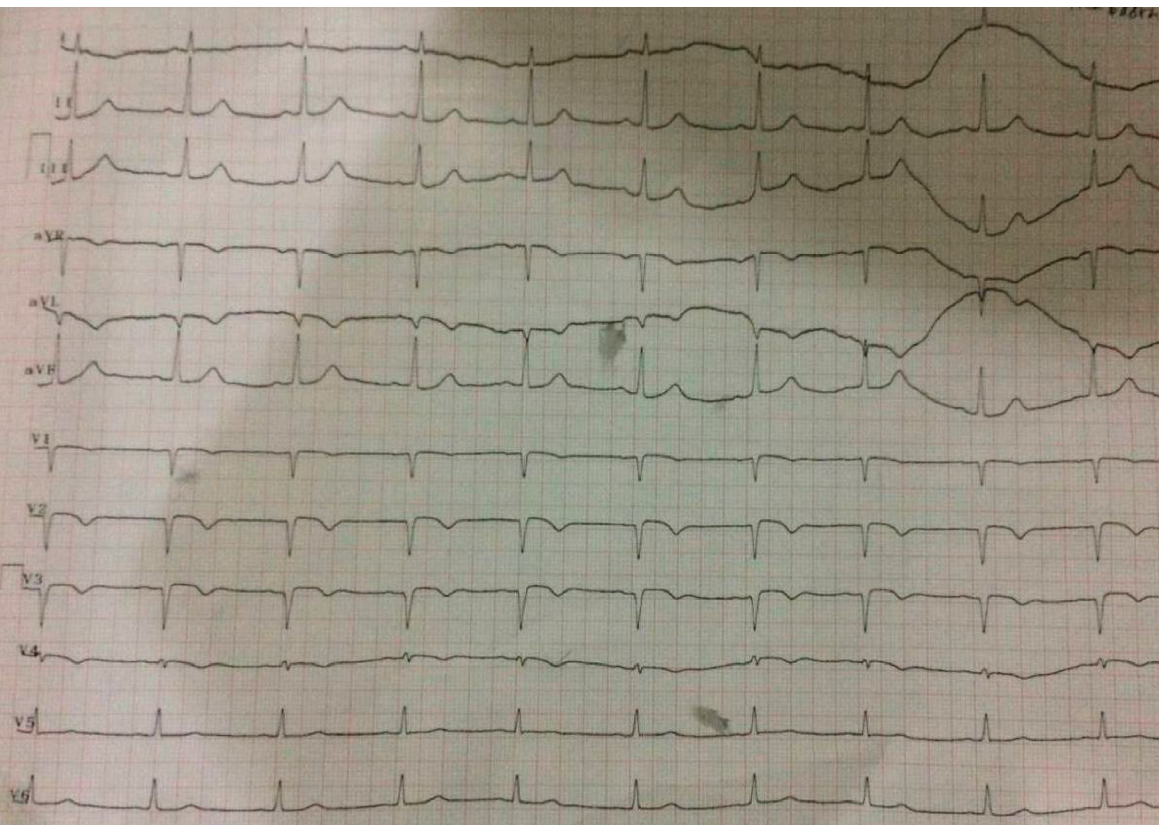
Figure 3: ECG after fibrinolysis showing resolution of ST-segment